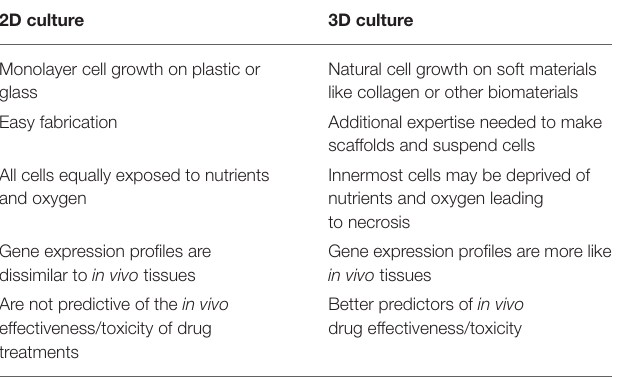
TABLE 2 | Key differences between 2D and 3D culture